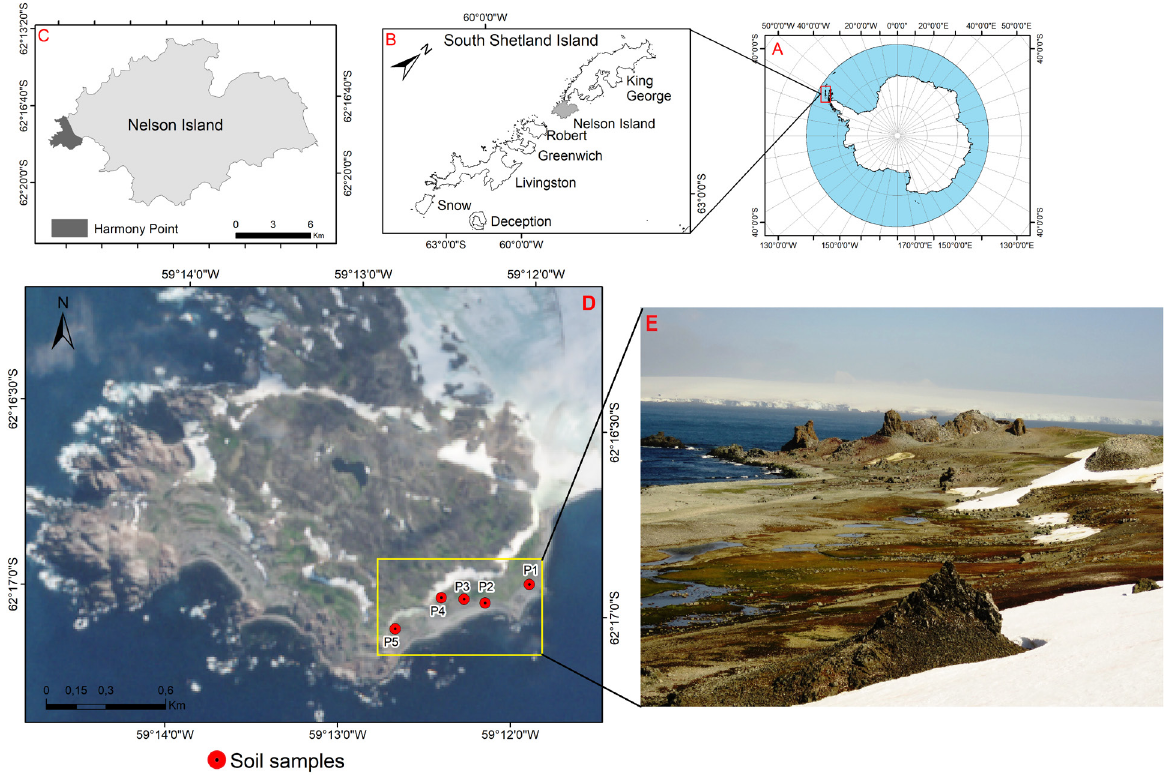
Figure 1. Location of the studied area, Harmony Point, Nelson Island, Maritime Antarctica. A: Location of South Shetland Island in the Continent Antarctica. B: Location of South Shetland Islands. C: Nelson Island and Harmony Point location, D: Harmony Point area; E: Coastal domain location of the sampled soil